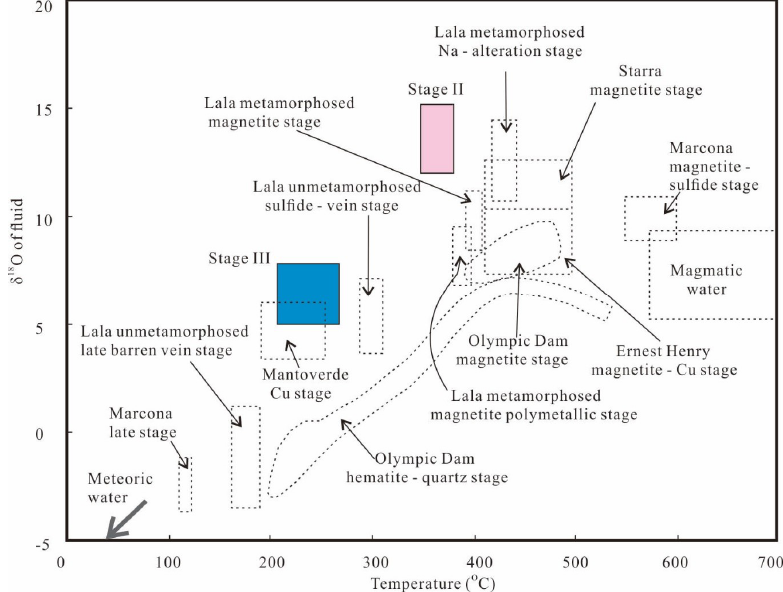
Figure 12 Figure 12. δ 18 O–temperature relationships of the calculated fluids of the Xianglushan Stage II and III fluids and other IOCG deposits in the world. Data for Lala and other IOCG deposits are from